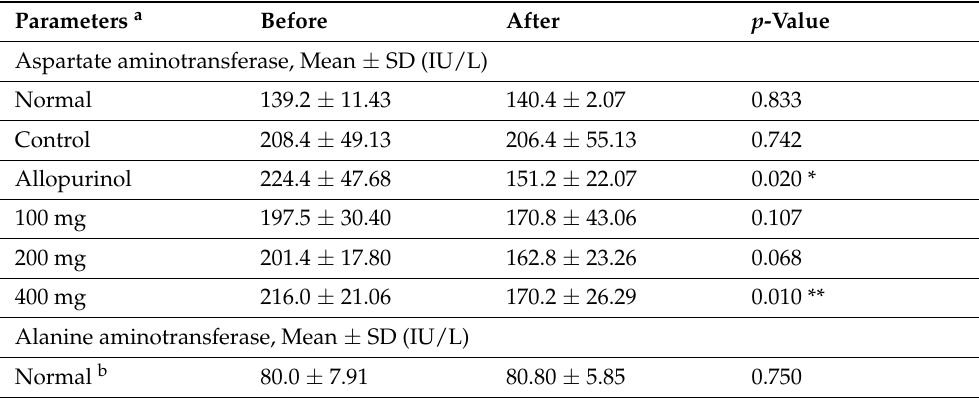
Table 4. Levels of serum aspartate aminotransferase and alanine aminotransferase before and after the